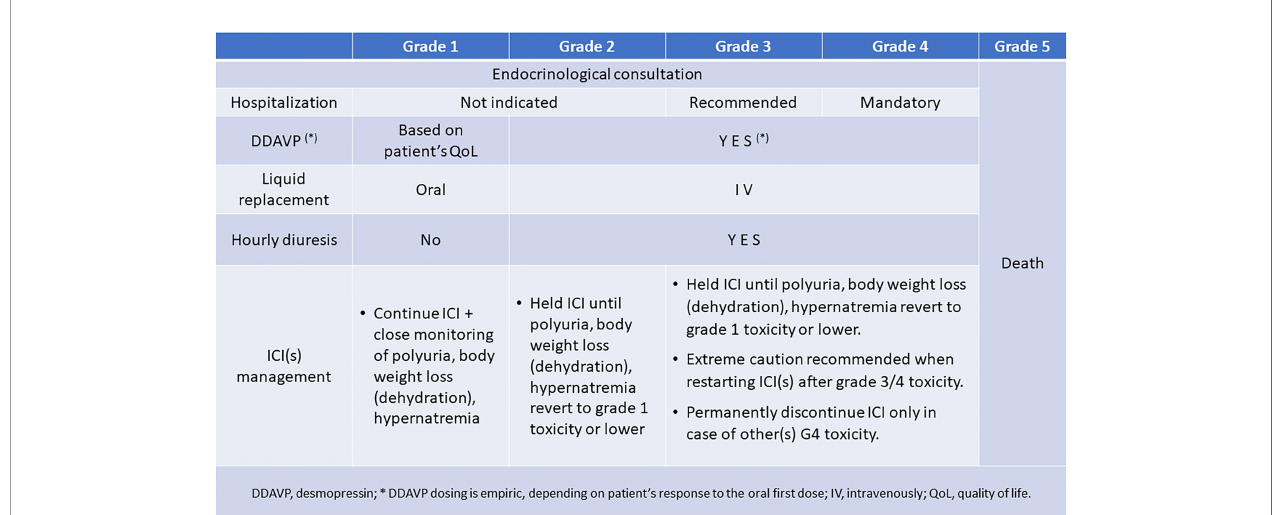
FIGURE 1 | The suggested management of desmopressin and ICI(s) in patients with ICI-induced